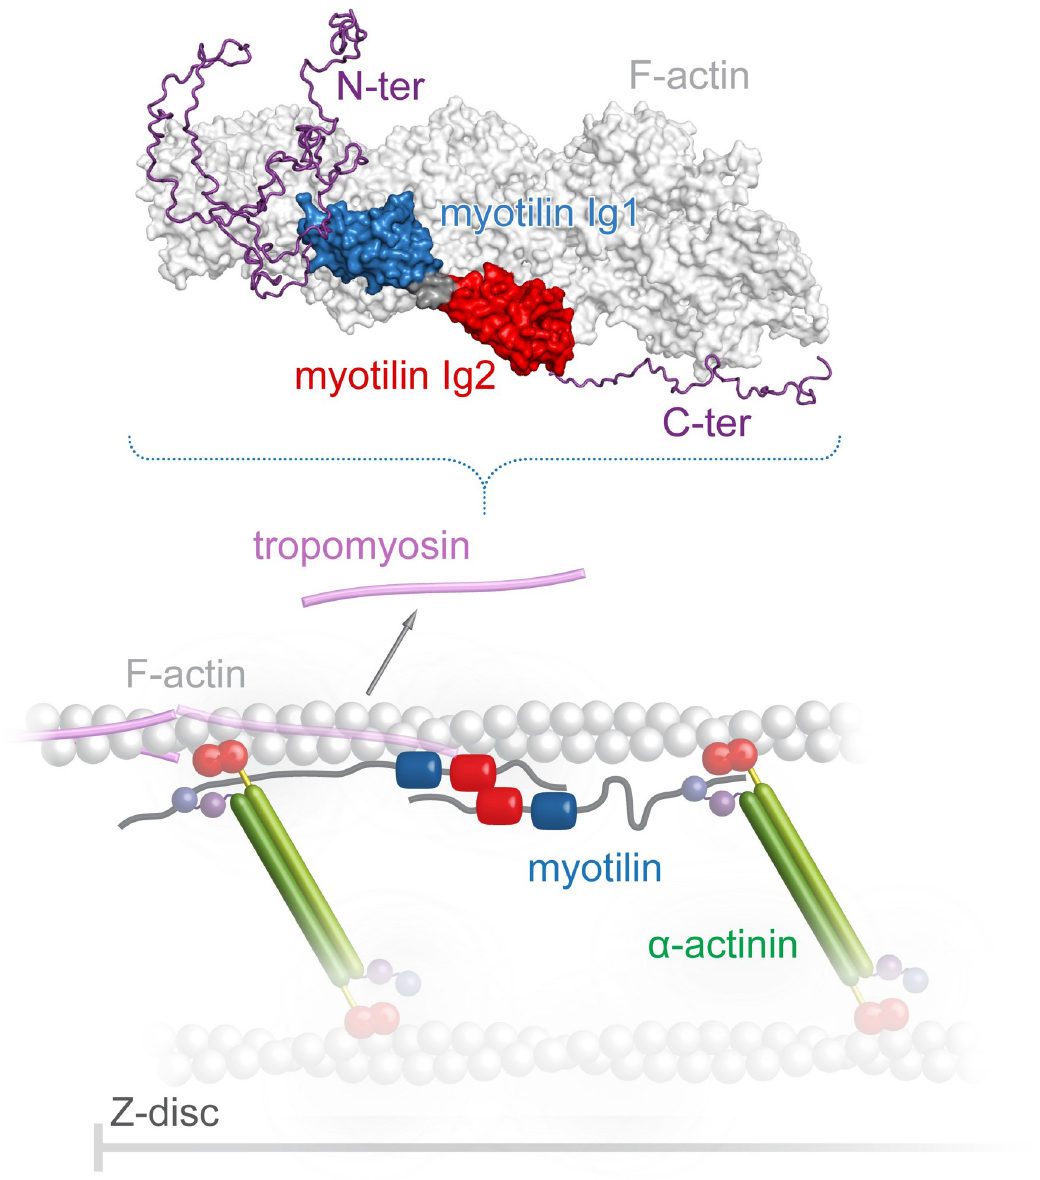
Fig 6. Model illustrating the role of myotilin in the organization of sarcomeric Z-disc assembly. Myotilin is recruited to the Z- disc by binding to F-actin, α -actinin-2, and/or other Z-disc components e.g., filamin C, ZASP. As a part of the recruitment process, myotilin can further stabilize (in its propose antiparallel dimeric form) [11] 2 α -actinin-2 dimers on F-actin through interaction of its N-terminal region with CAMD of α -actinin-2. Consequently, together with α -actinin-2 and/or other Z-disc components, myotilin can help to displace tropomyosin from the Z-disc. For simplicity, only some of the Z-disc components are shown. α -Actinin-2 dimers are schematically shown in an open conformation bound to myotilin, with ABD highlighted as red spheres and EF12 and EF34 of CAMD as violet and purple spheres, respectively. Myotilin and tropomyosin are shown in color code as used in Figs 1B and 4A. The 3D model presented in this panel is available in the following link: https://skfb.ly/6YGQF. ABD, actin binding domain; CAMD, calmodulin-like